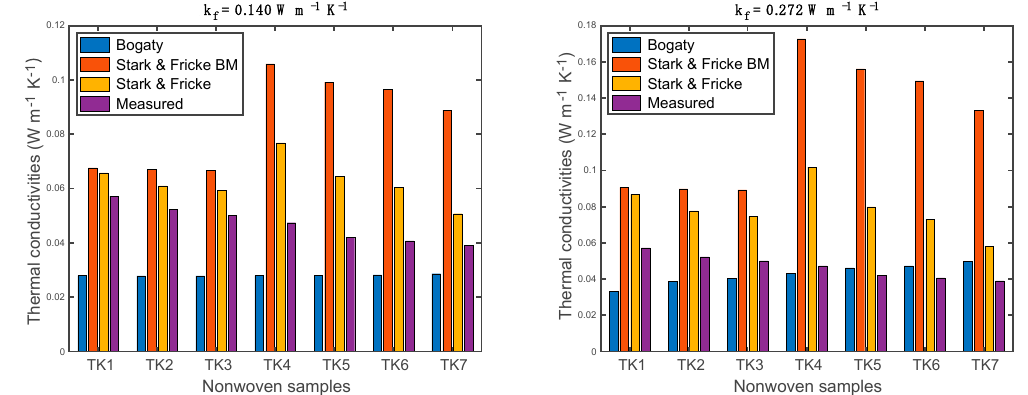
Figure 12. Predicted and measured thermal conductivities of the nonwoven samples.